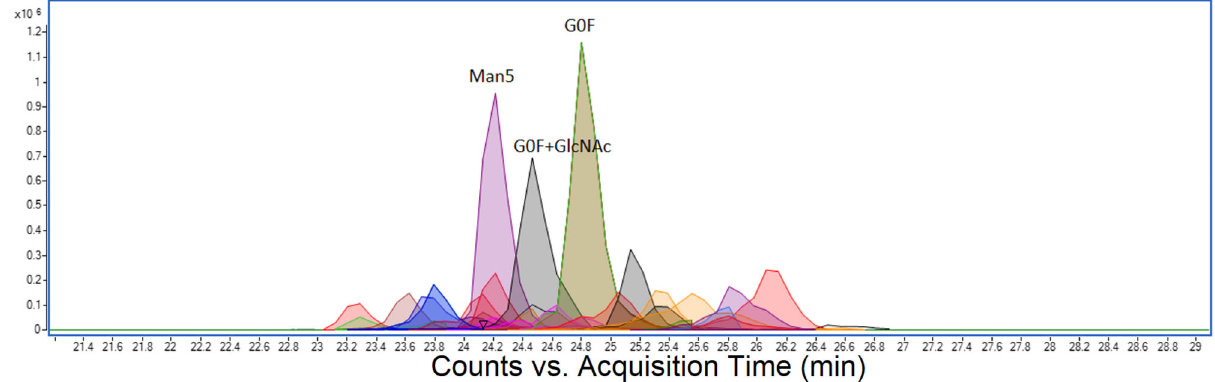
Fig. 3 Combined extracted ion chromatogram (EIC) for 27 species of glycopeptide GEVFNAT (N343). All 27 glycoforms elute within + / − 2-min retention-time window. Only three glycans are labeled, the remainder are listed in the accompanying Table 1.